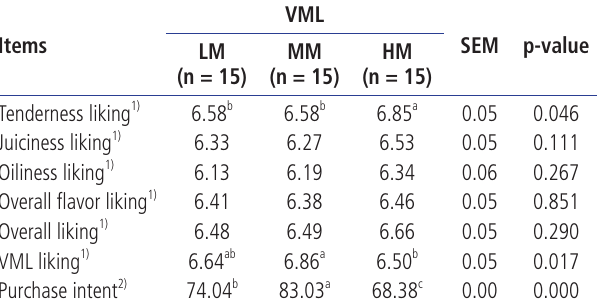
Table 3. Effects of visual marbling level (VML), categorized as low (LM, score 1-2), moderate (MM, score 3-4), and high (HM, score 5-6) according to the